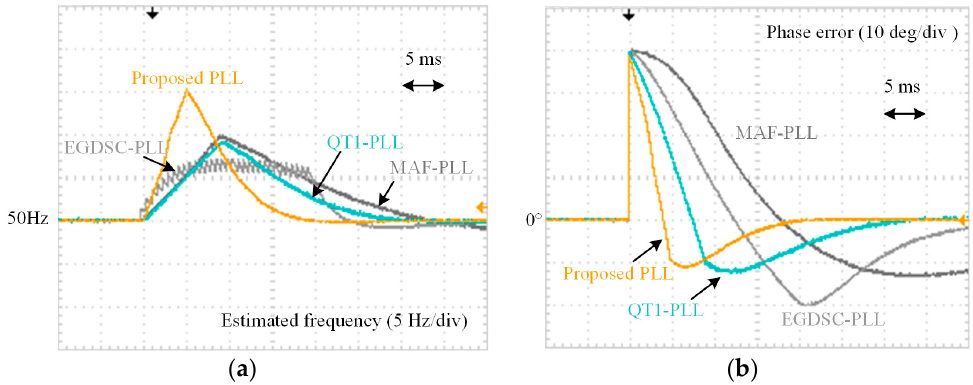
Figure 20. The experimental results of test case 1. ( a ) Estimated frequency and ( b ) phase error.